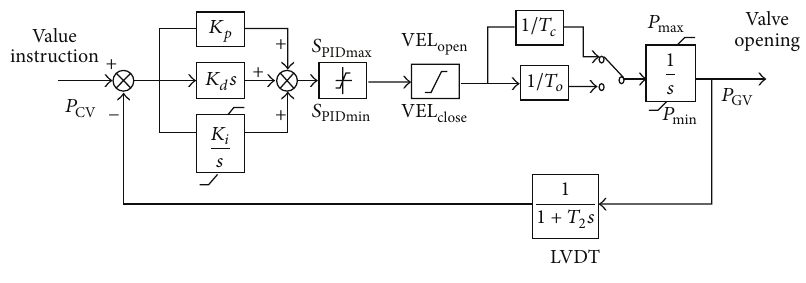
Figure 1: Servo and actuator system model.